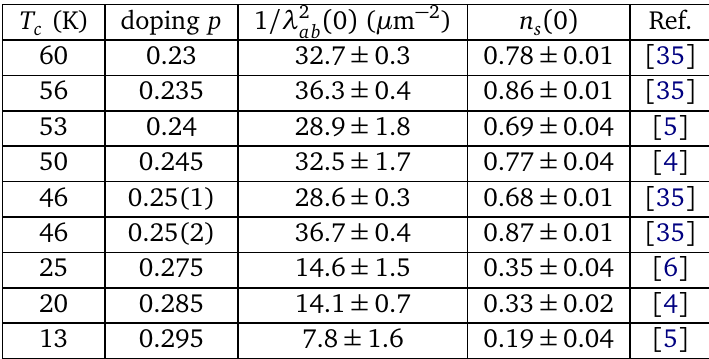
Table 4: Estimated superfluid density n and microwave surface impedance [ 6 ]